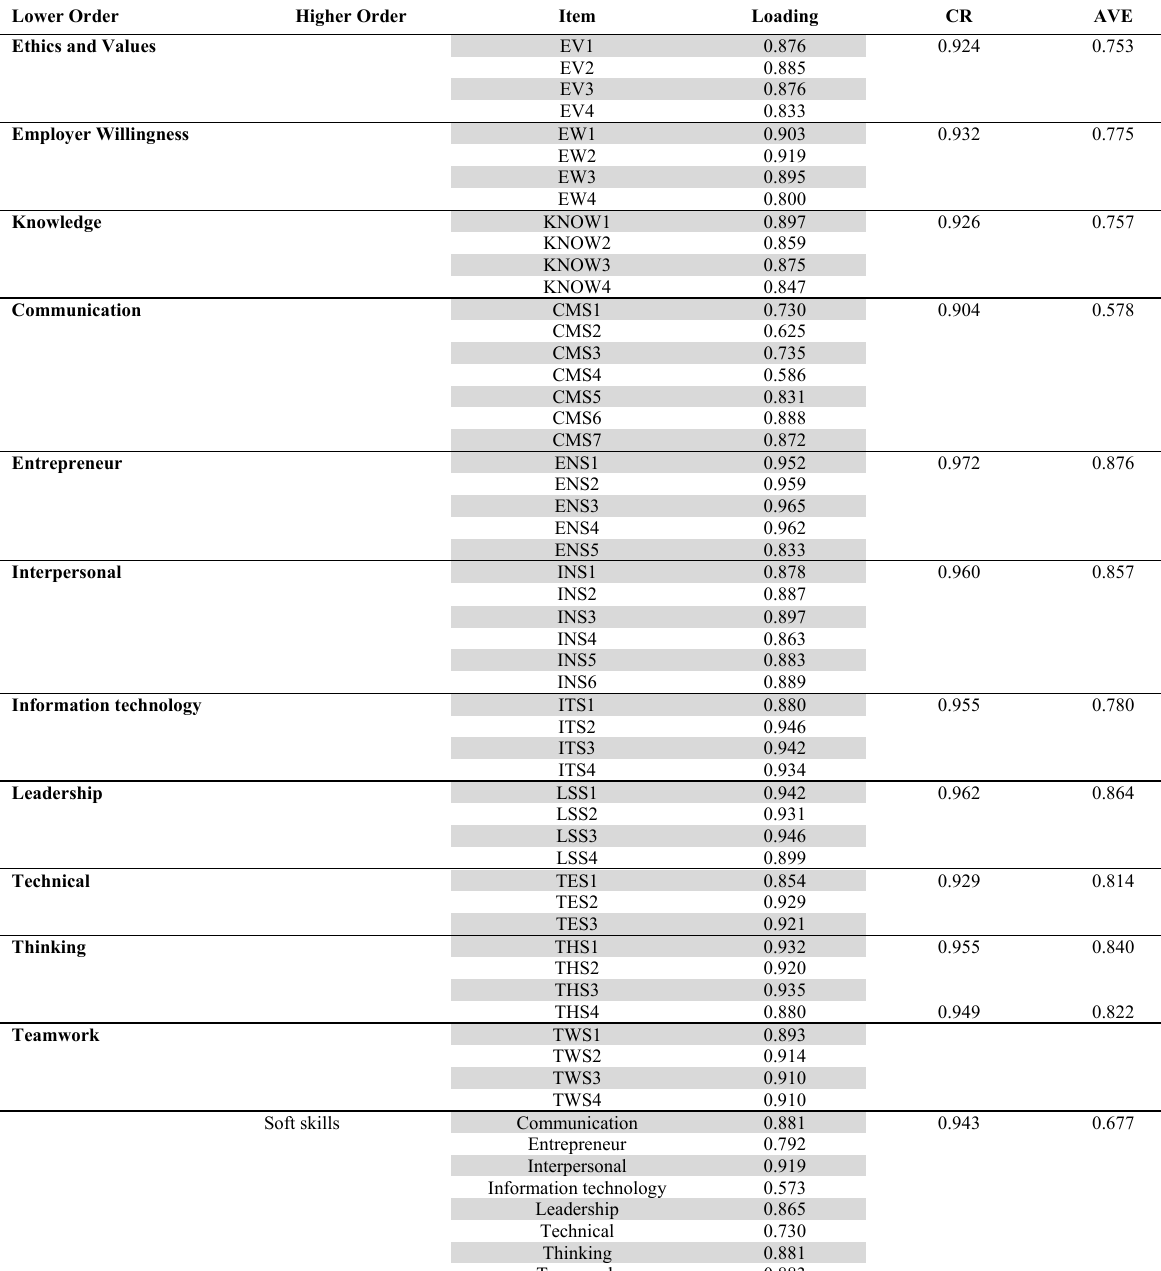
Convergent validity Lower Order Higher Order Item Loading CR Ethics and